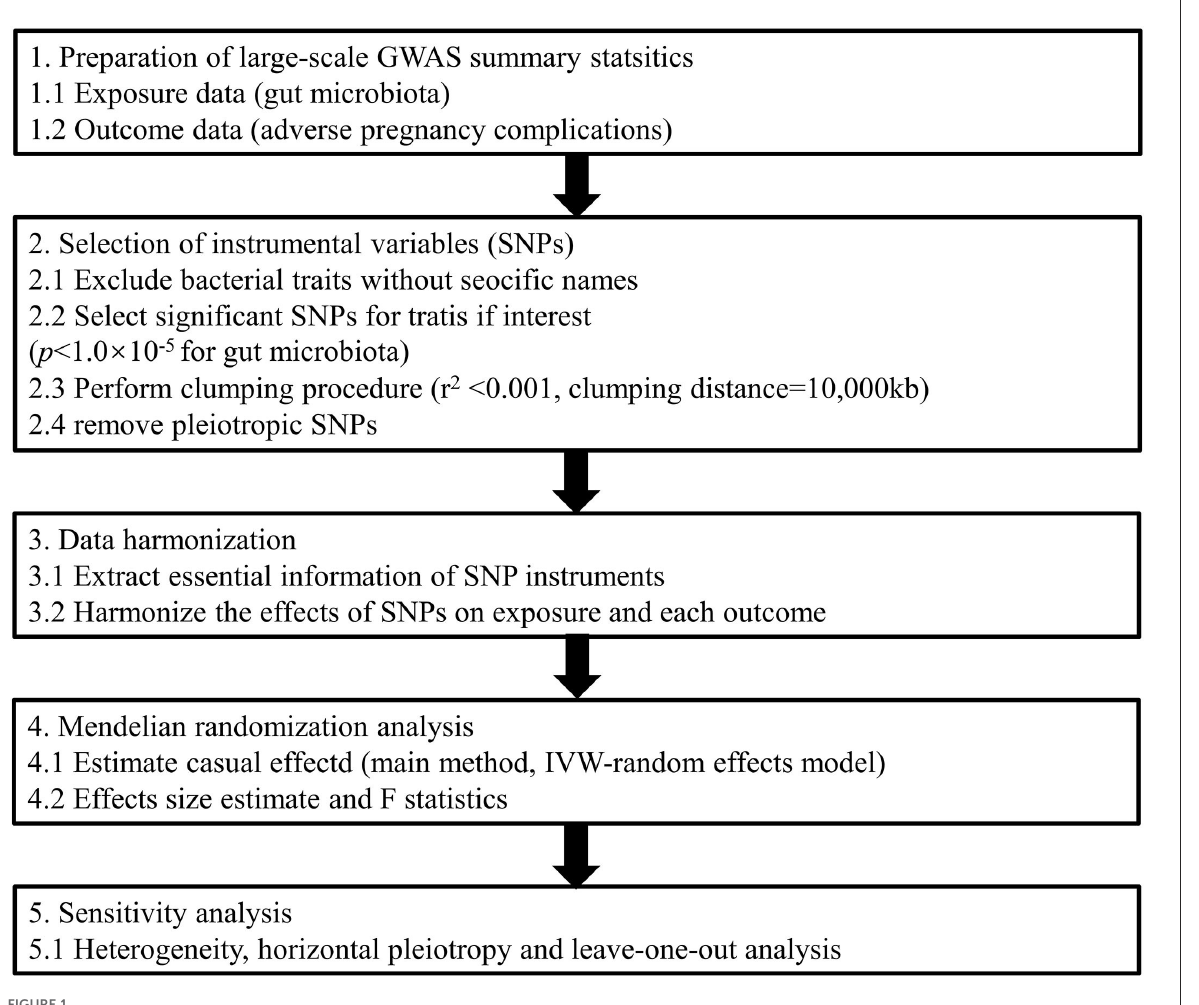
FIGURE1 Study design of the present MR study on the associations of gut microbiota and adverse pregnancy complications. SNP, single-nucleotide polymorphism; IVW, inverse variance-weighted; MR, Mendelian randomization.